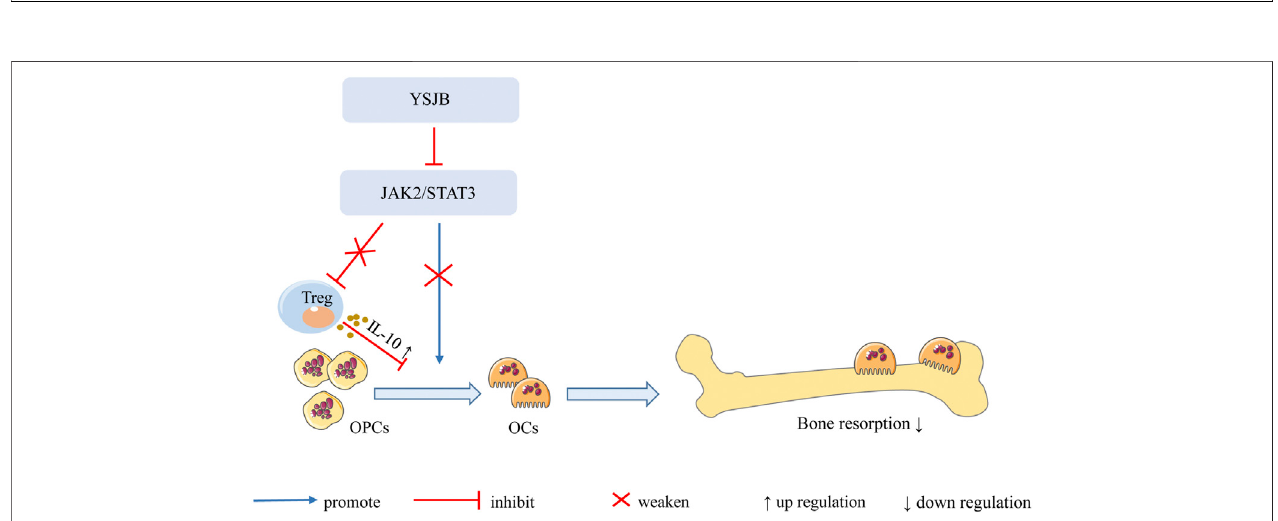
FIGURE 9 | Mechanism of YSJB regulates the bone immune microenvironment. YSJB directly regulates the JAK2/STAT3 signaling pathway in OCs, thereby inhibiting OC differentiation and bone loss. Moreover, YSJB regulates the JAK2/STAT3 signaling pathway in Tregs and upregulates the expression of IL-10. YSJB enhances the immunosuppressive function of Tregs and indirectly inhibits OC differentiation and bone loss.